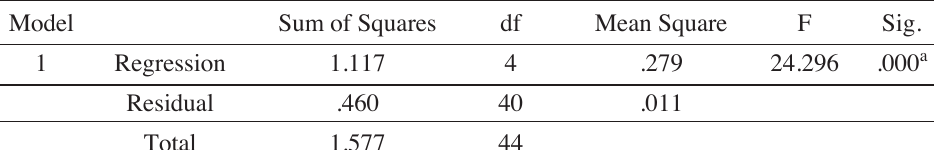
Table 4: Analysis of Variance